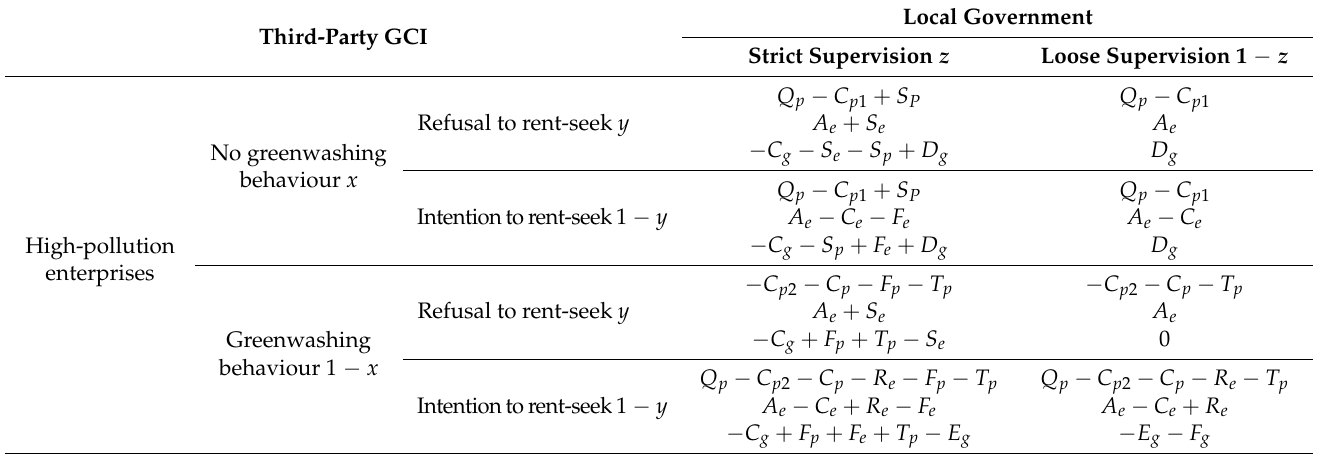
Table 1. Payoff matrix of high-pollution enterprises, local governments, and third-party GCIs. Local Government Third-Party GCI Strict Supervision z Loose Supervision 1 − z